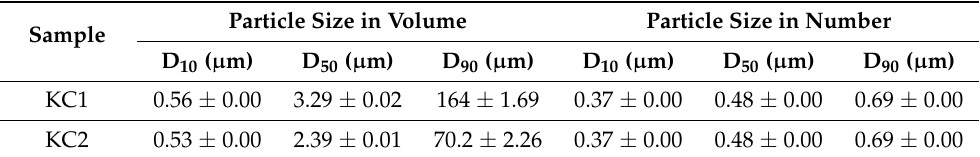
Table 1. Particle size in volume and number expressed as D 10 , D 50 , and D 90 .